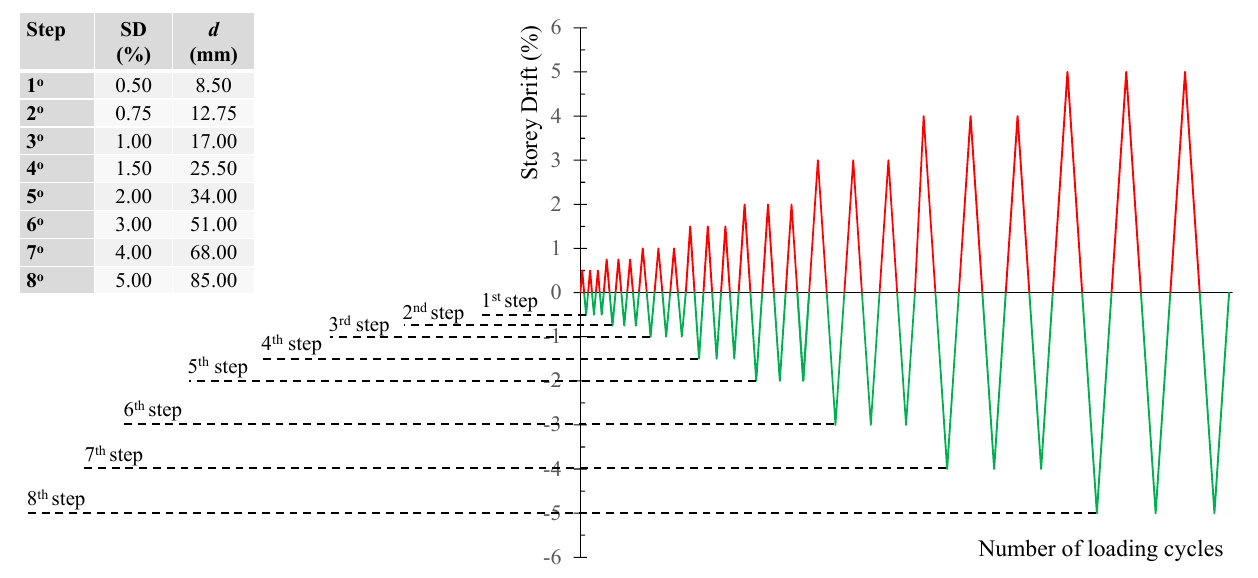
Figure 4. Cyclic reversal loading sequence: eight (8) loading steps consisting of three (3) full loading cycles at each loading step.